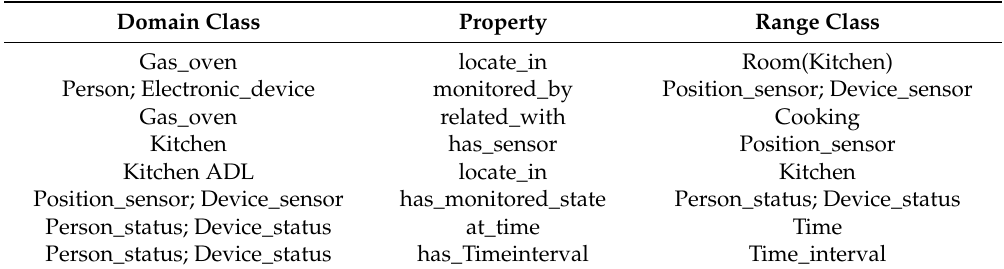
Table 4. An example of class hierarchy related with a “cooking”